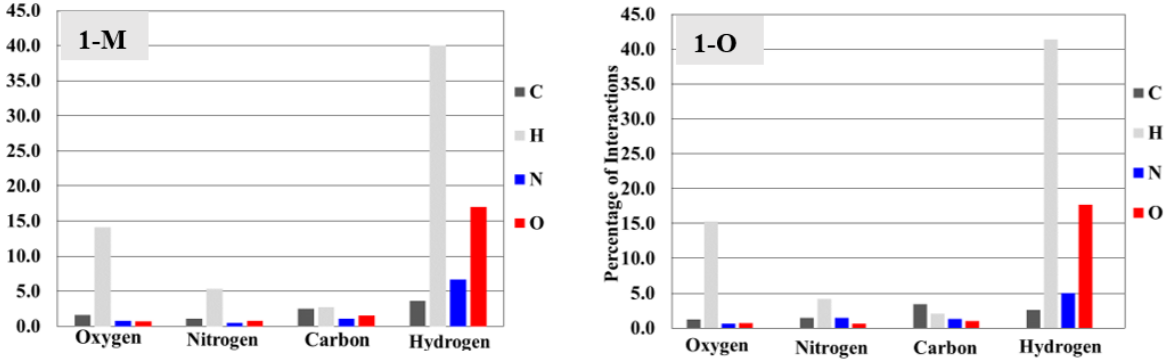
Figure 6. Bar graphs representing the percentages of interactions between atoms derived from the Hirshfeld surface. For example, 1-M displays ~40% hydrogen interactions with hydrogens (tallest gray bar).